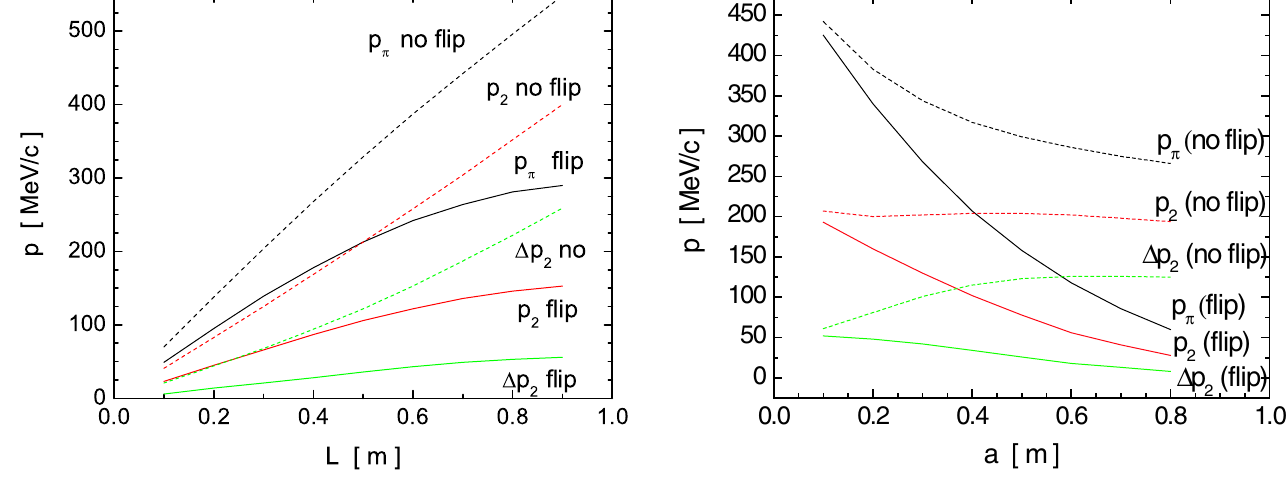
FIG. 5. (Color) Location of the (cid:8) resonance, and the midpoint and width of the second band as a function of L . The other parameter values were d (cid:2) 100 cm , a (cid:2) 40 cm , t (cid:2) 10 cm , and J (cid:2) 100 A = mm 2 .